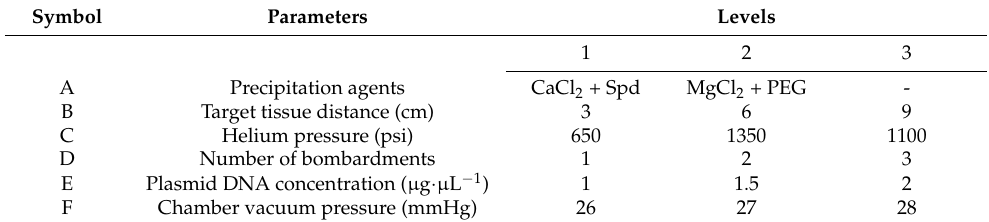
Figure 1. Particle-bombardment-mediated genetic transformation system optimization strategy of E. breviscapus . Table 3. Parameters and levels involved in this study.